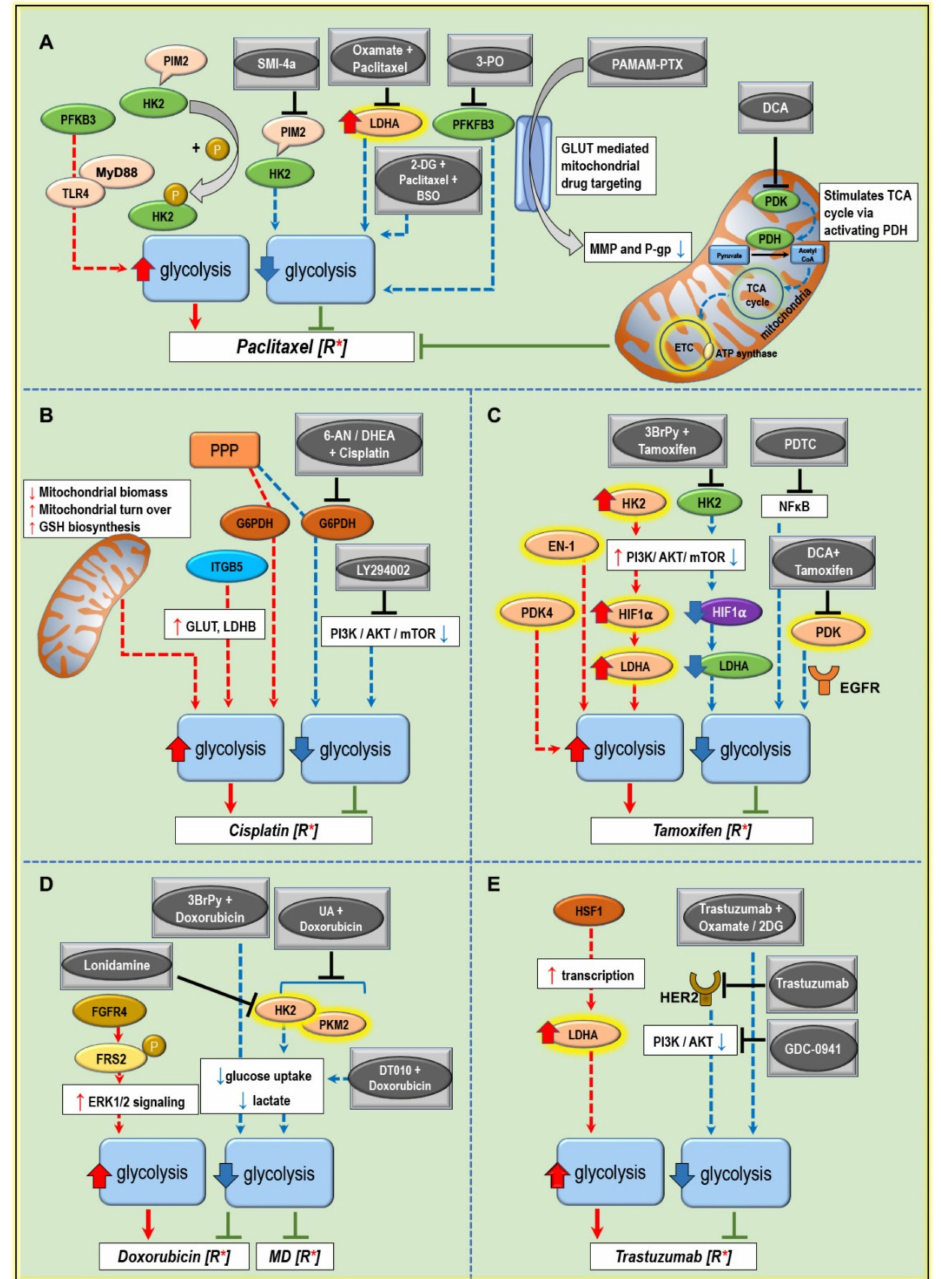
Figure 2. Illustrating the metabolic components contributing to drug resistance and drugs to overcome the resistance. The five panels show various signaling pathways converging to increased glycolysis and drugs as monotherapy or combinations that modify these pathways, which help to reverse the resistance mechanism. ( A ) Metabolic components contributing to paclitaxel resistance include upregulated expression of GLUT, HK2, LDHA, and PFKFB3, thereby switching the metabolism of cancer cells to aerobic glycolysis. Drugs targeting these enzymes potentially downregulate aerobic glycolysis, lactate production, and drug e ffl ux pumps. PAMAM-PTX is a conjugated drug targeted